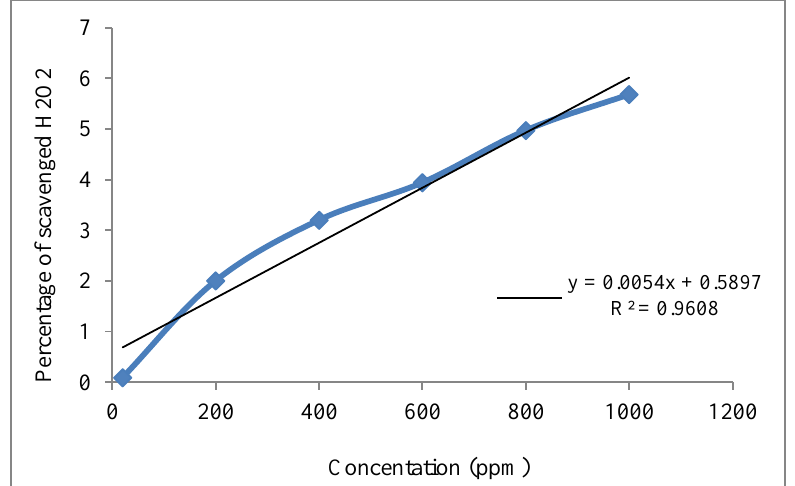
Figure 8. H 2 O 2 Scavenging activity of C 2